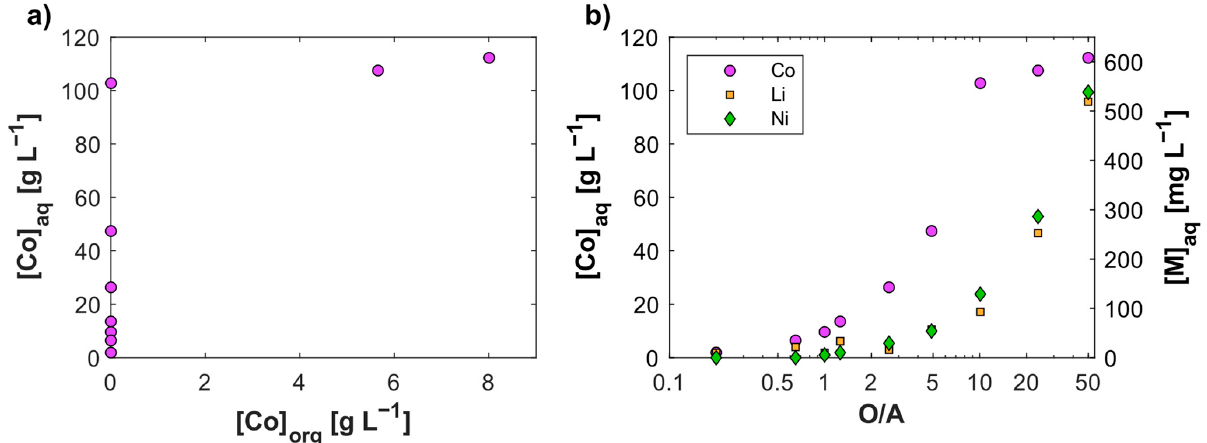
Figure 8. Backextraction of Co, Li, and Ni by 2 M H 2 SO 4 from loaded 0.8 M Cyanex 272 (diluted in Exxsol D80): ( a ) Equilibrium distributions of Co; ( b ) Effect of O/A ratio on the metal concentrations in the stripping raffinate. T = 25 ± 1 °C; t eq = 15 min. Initial concentrations in the organic phase: 10.2 g L − 1 Co, 10.5 mg L − 1 Li, and 10.1 mg L − 1 Ni. Note the logarithmic O/A-axis and secondary y -axis for Ni and Li in subfigure ( b ).